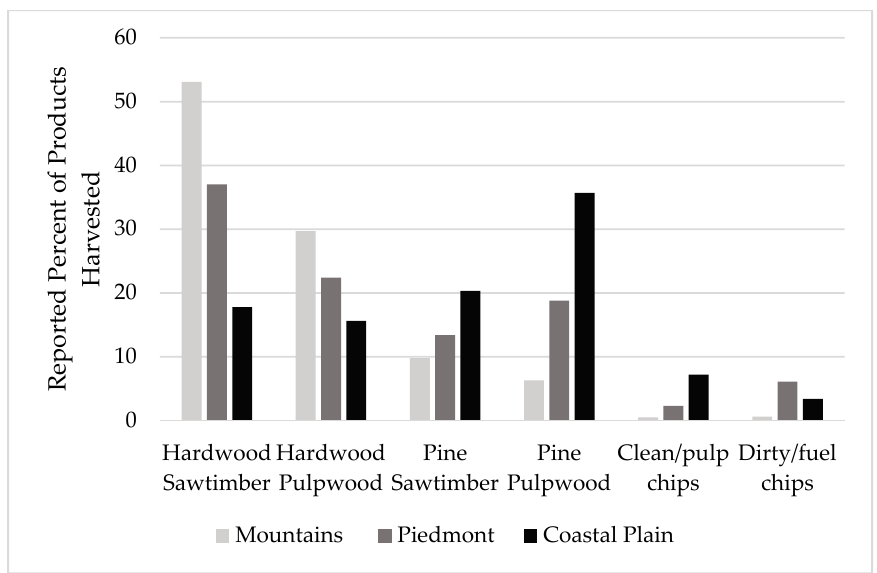
Figure 3. Reported percentage of products harvested in the past year by physiographic region.